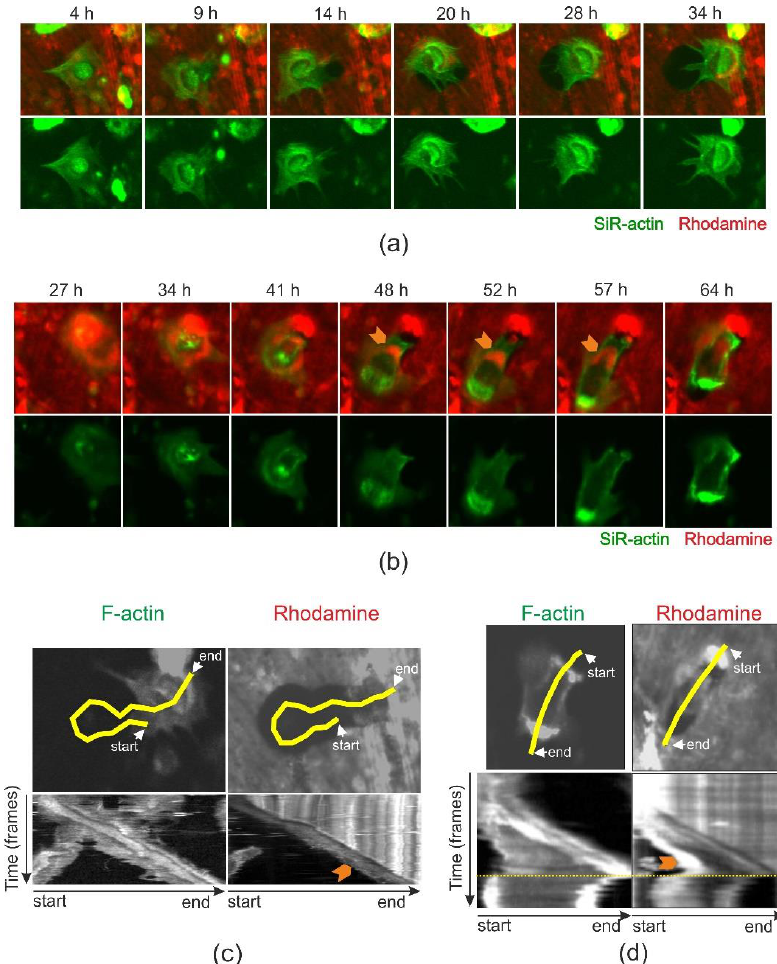
Figure 3. Time-lapse analyses document that 10 µ M chloroquine makes trench-forming OCs stop prematurely. Representative images selected from one 70 h time-lapse recording. ( a ) Images from control condition (Supplementary Materials Movie 1) showing selected time-lapse images out of 70 h total recording time. The images show an OC making a pit and subsequently switching into trench formation. The width of each image is 122.6 µ m. ( b ) Images from the chloroquine condition (10 µ M chloroquine added 4 h prior to start of recording, Supplementary Materials Movie 2), showing selected time-lapse images from a total recording of 70 h. The images show an OC making a pit and subsequently switching into trench formation. The width of each image is 176.4 µ m. ( c ) Kymograph analysis of the control OC shown in (a) and Supplementary Materials Movie 1 showing SiR-actin or rhodamine signals throughout the time-lapse recording. The upper images show the trace line (yellow) that reflects movement of the OC (left) or the resorption front (right) over time and along which the fluorescent intensities are measured. The images reflect the end stage of the time-lapse recording. The lower images show the kymographs reflecting the intensity of f-actin or rhodamine over time along the yellow line. The absence of accumulated rhodamine signal in the OC is marked by an orange arrow. ( d ) Kymograph analysis of the chloroquine treated OC shown in (b) and Supplementary Materials Movie 2 showing SiR-actin or rhodamine signals throughout the time-lapse recording. The upper images show the trace line (yellow) that reflects movement of the OC (left) or the resorption front (right) over time and along which the fluorescent intensities are measured. The images reflect the end stage of the time-lapse recording. The lower images show the kymographs reflecting the intensity of f-actin or rhodamine over time along the yellow line. The time point where the front of the resorbing OC detaches and resorption stops is marked by a narrow yellow dotted line. The accumulation of rhodamine signal in the OC just prior to termination of bone resorption is marked by an orange